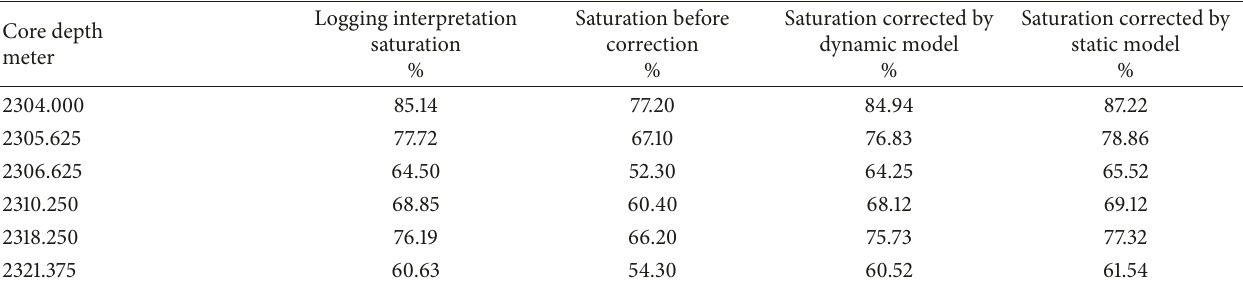
Figure 2: Comparison between ground water saturation and water saturation corrected by dynamic model in Well D400217. The logging information is shown at the first to forth columns as “RT,” “GR,” “PERM,” and “SW” in this figure. RT means resistivity log. GR means gamma ray. PERM means permeability. And SW means water saturation. And the corrected water saturation is also listed in this figure at the last two columns. Table 1: Saturation test of Well